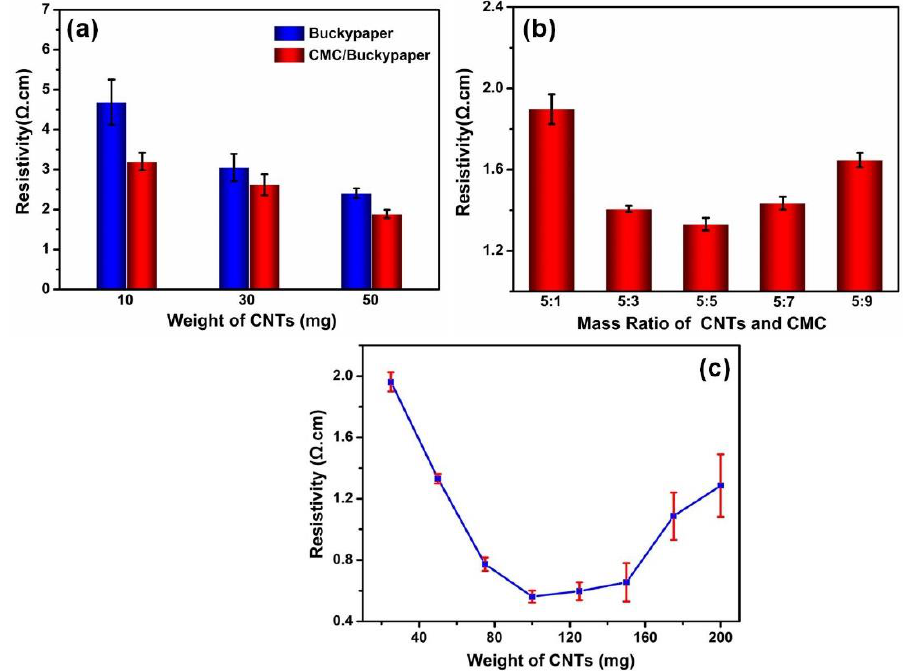
Figure 3. The resistivity of buckypaper ( a ) adding CMC as a binder; ( b ) the different mass ratio of carbon nanotubes (CNTs) and CMC; ( c ) the different weight of CNTs.